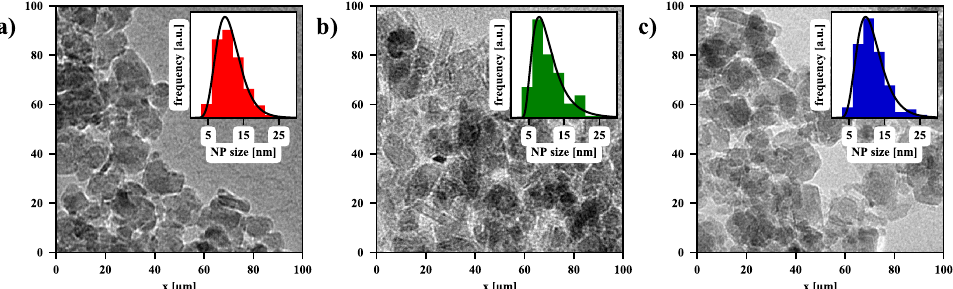
Figure 3. The TEM images for ( a ) the bare NPs, ( b ) NPs from the solution at the pH = 11.5 and ( c ) NPs from the solution at the pH = 11.5 subjected to the 1800-s RFMH (the particle size distribution histograms and log-normal fittings are presented as the insets).